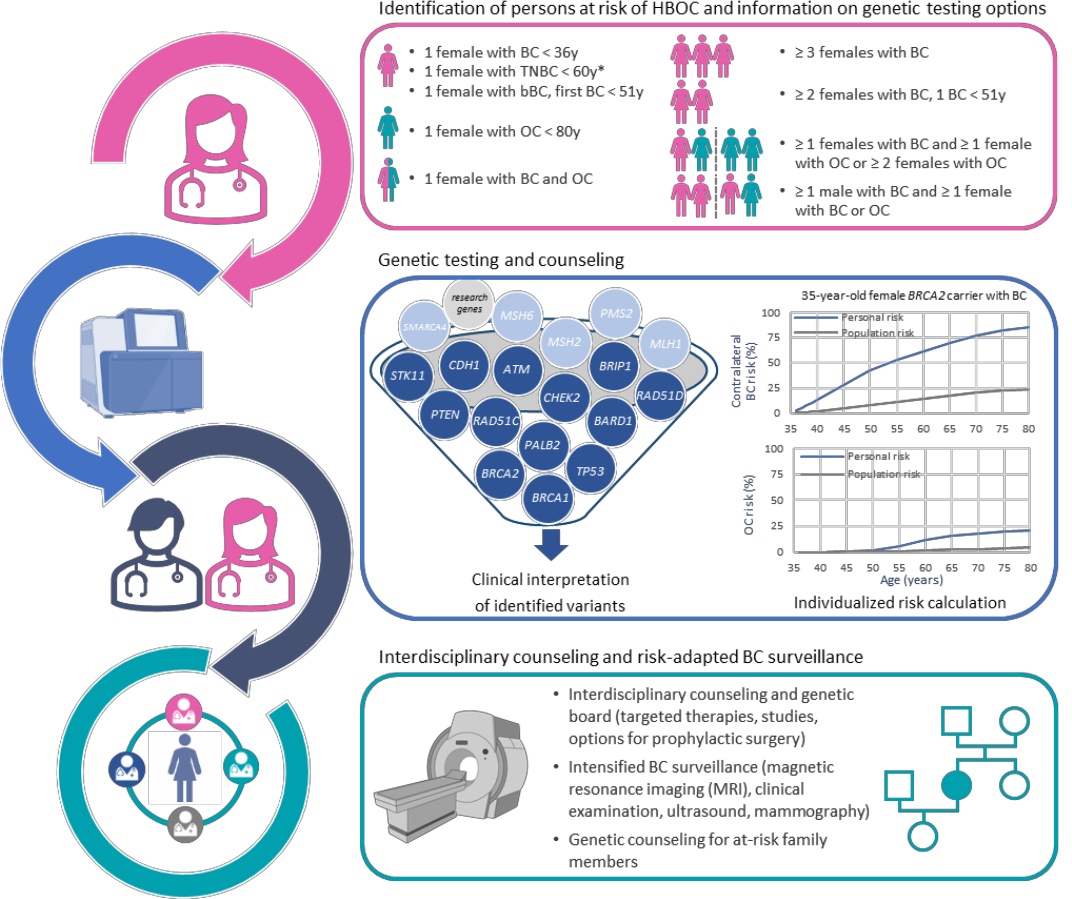
Figure 3. Integrated care for HBOC patients by an interdisciplinary team of experts at specialized Familial Breast and Ovarian Cancer Centers. * Genetic testing of individuals with triple-negative breast cancer (TNBC) was extended to the 50-to-59 age group in 2022. Created with BioRender.com (accessed on 21 September